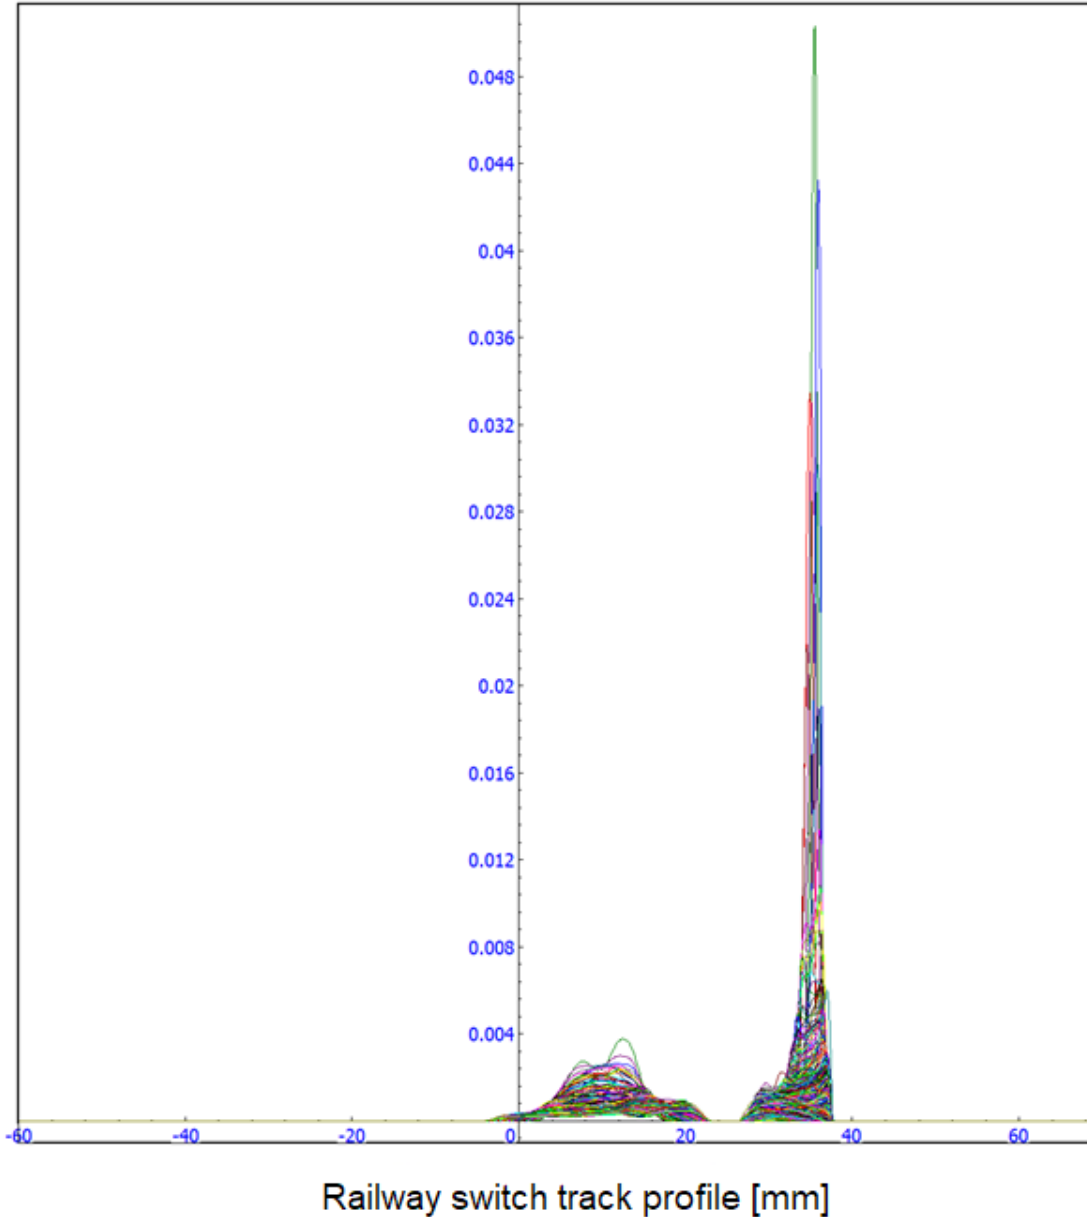
Figure 42. Wheel wear at 300 km/h for straight-track traffic through a turnout.